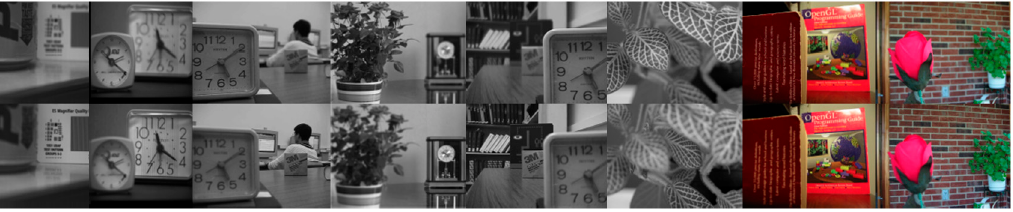
Figure 6. Eight pairs of popular multi-focus images.